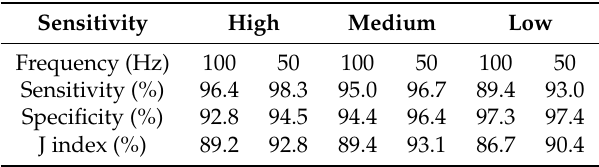
Table 2. Comparison of 100 Hz and 50 Hz sets of thresholds when tested with each respective test set, 30% of the dataset DS-1